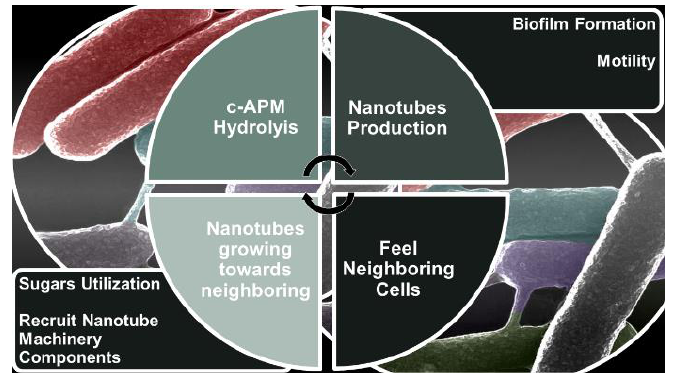
Figure 2. The many functions of